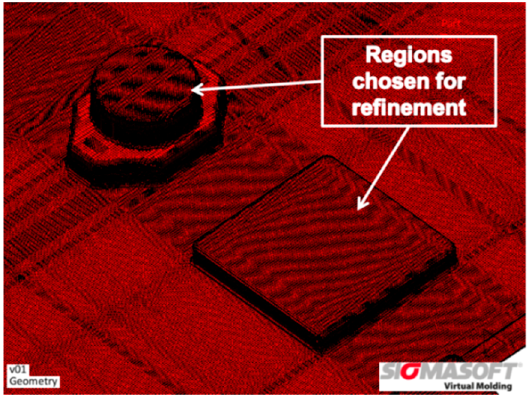
Figure 4. Fine mesh in the areas especially around the devices.